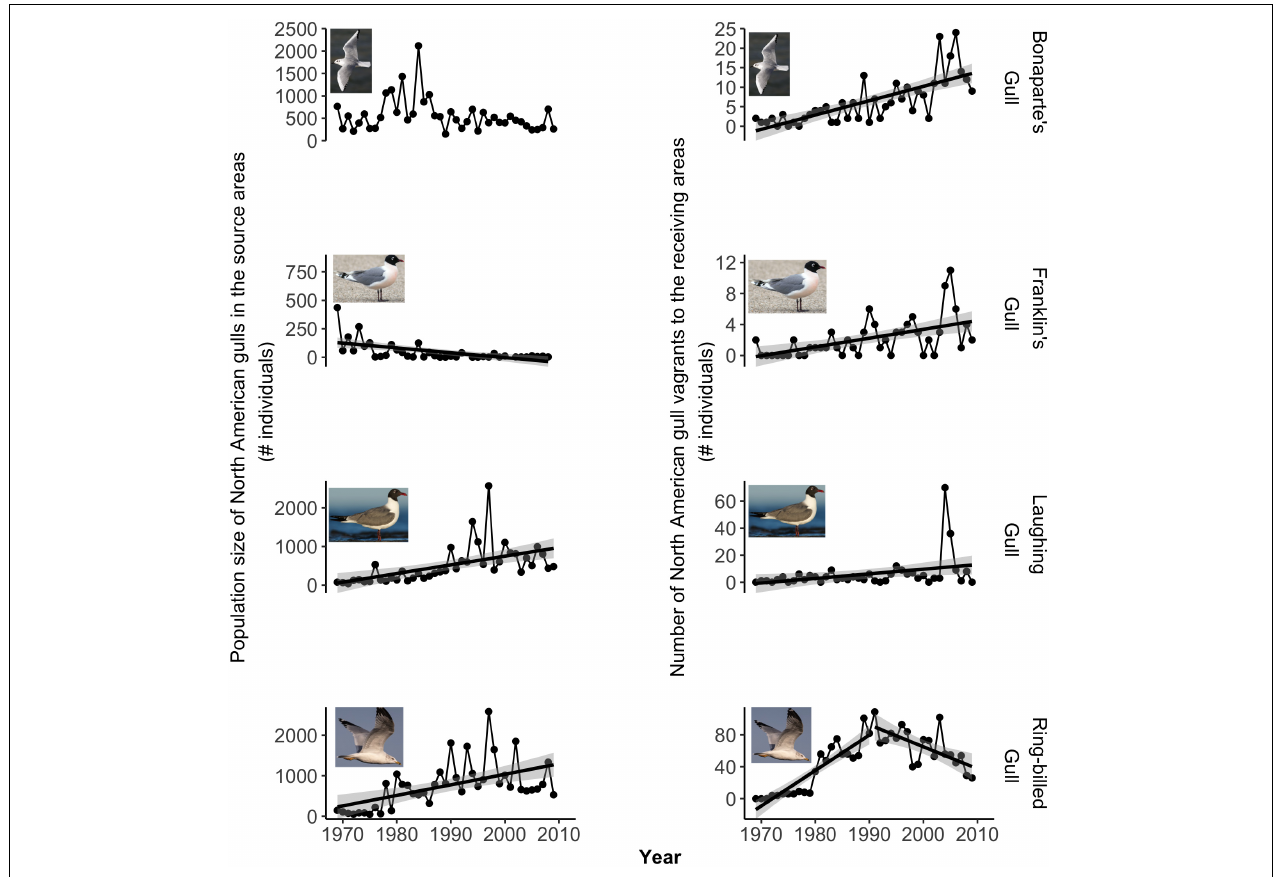
FIGURE 3 | Temporal trends for the North American gulls. Left column: Population size (1969–2009). Right column: Number of vagrants reported in the European receiving areas (1970–2010). Note that the y -axes have different scales.